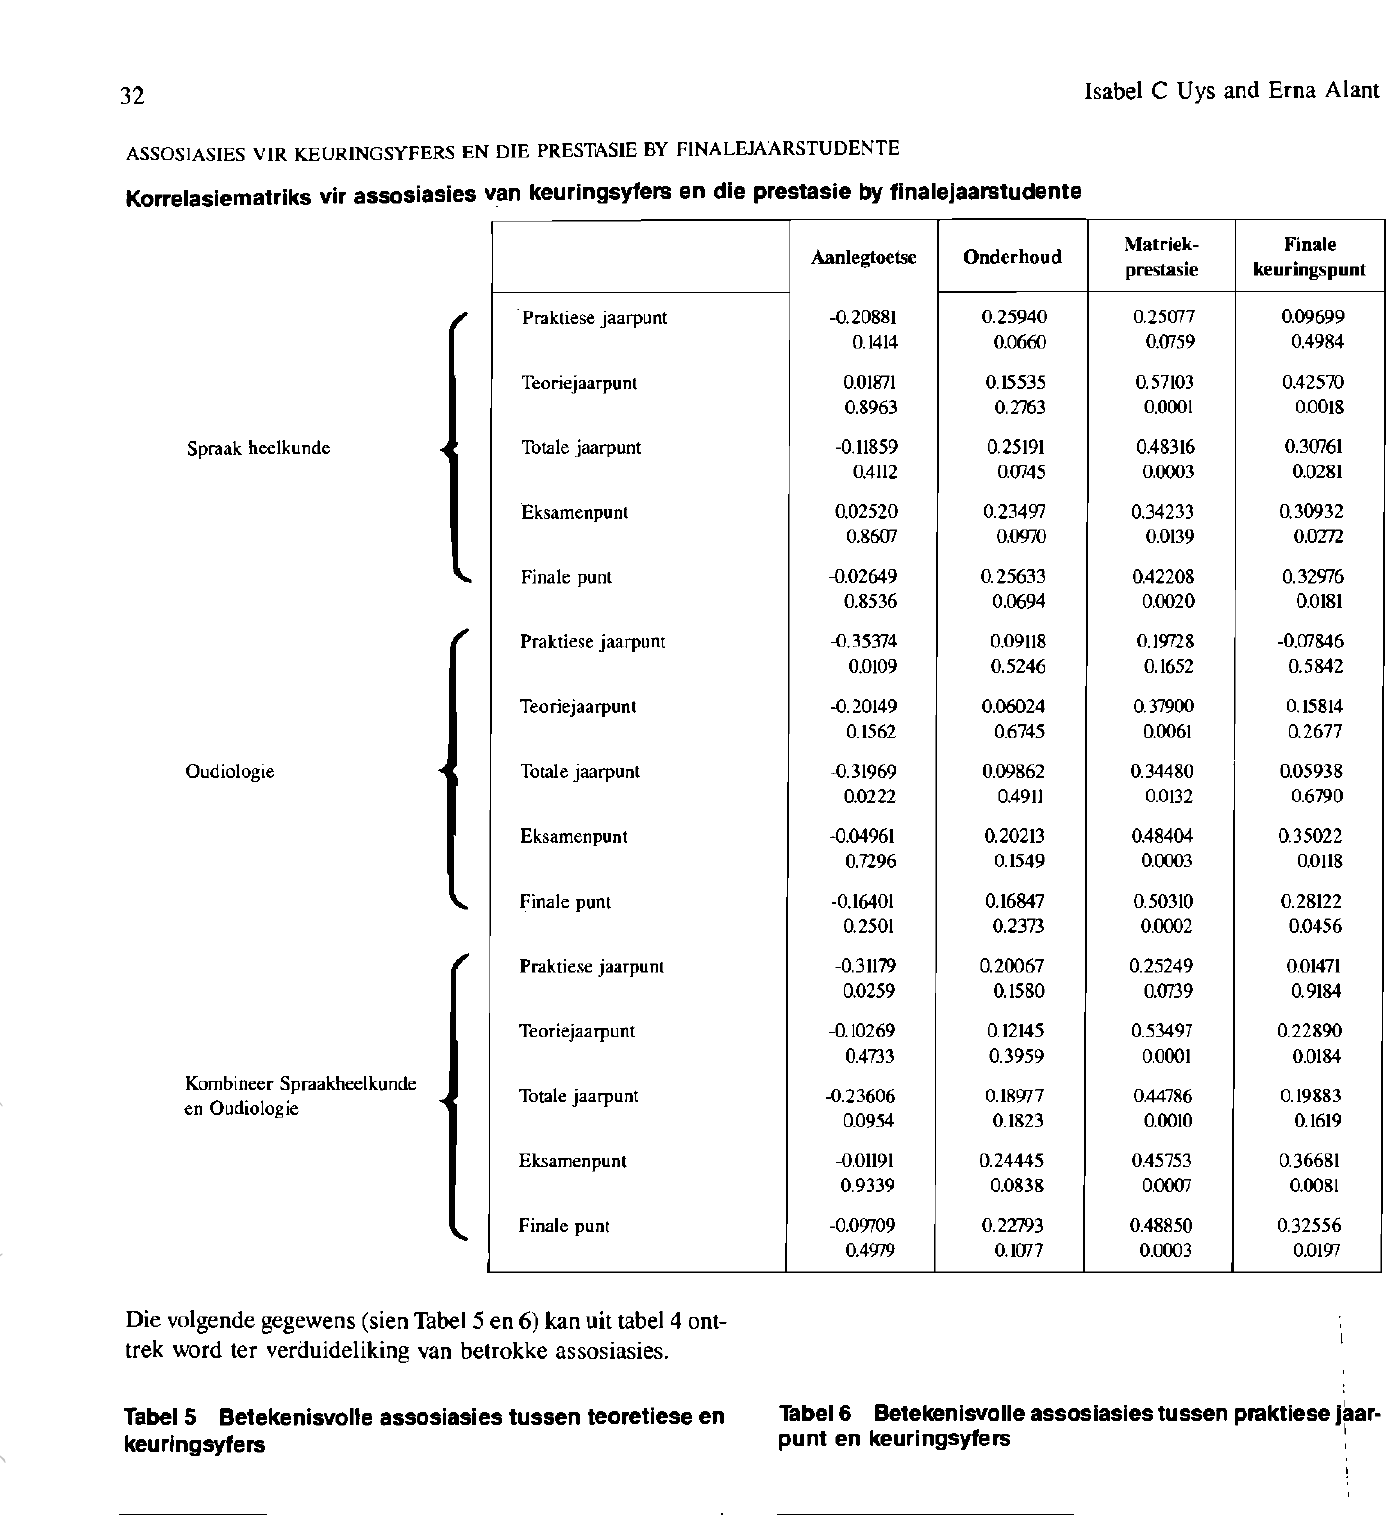
Tabel 5 Betekenisvolle assosiasies tussen teoretiese en keuringsyfers